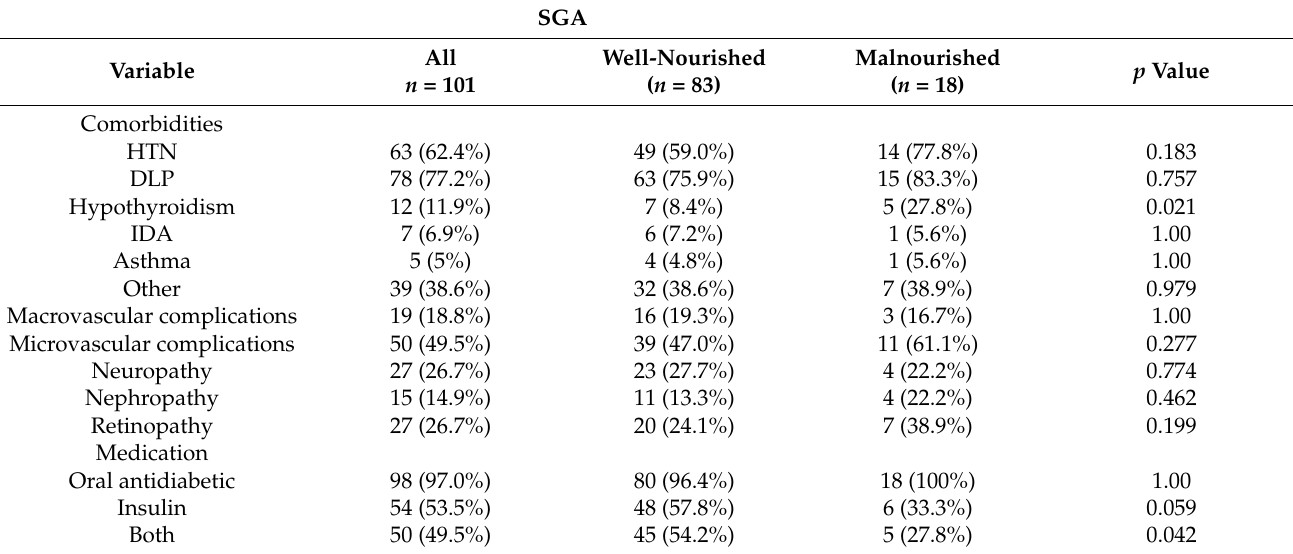
Table 4. Comorbidities, complications, and medication in patients with T2DM according to the SGA.